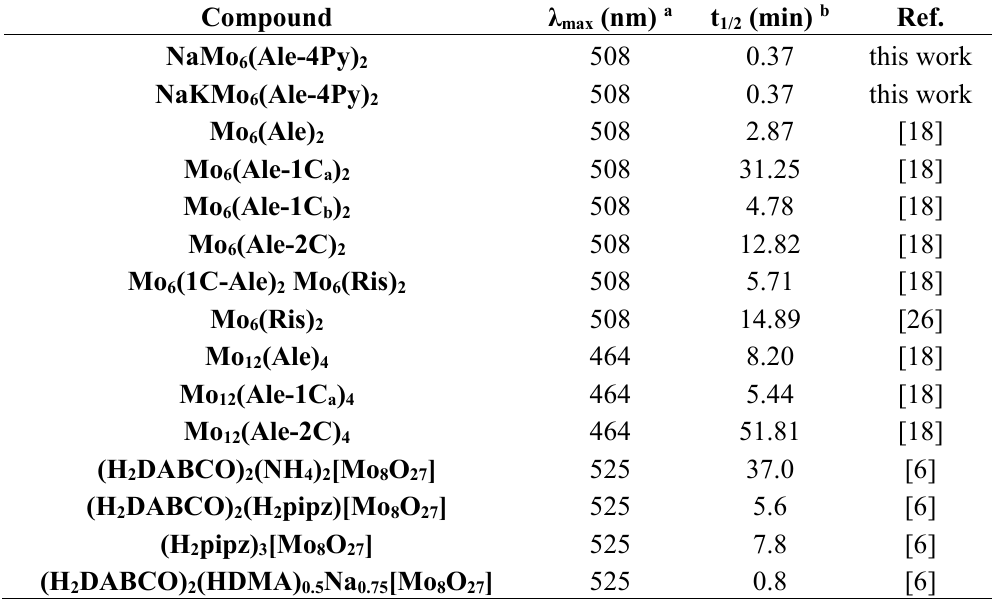
Table 1. Comparison of the t 1/2 values for various photochromic organoammonium/POM systems.